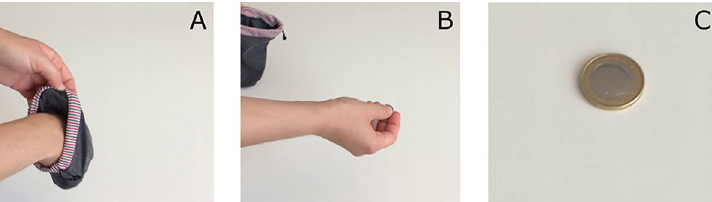
Fig 2. Results of the “replication” experiment. Screenshots of the coin flip experiment: (A) blind selection of coin and (B) flipping the coin (C) resulting in heads.